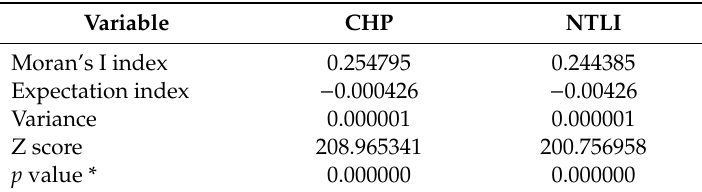
Table 1. Global Moran’s I summary.